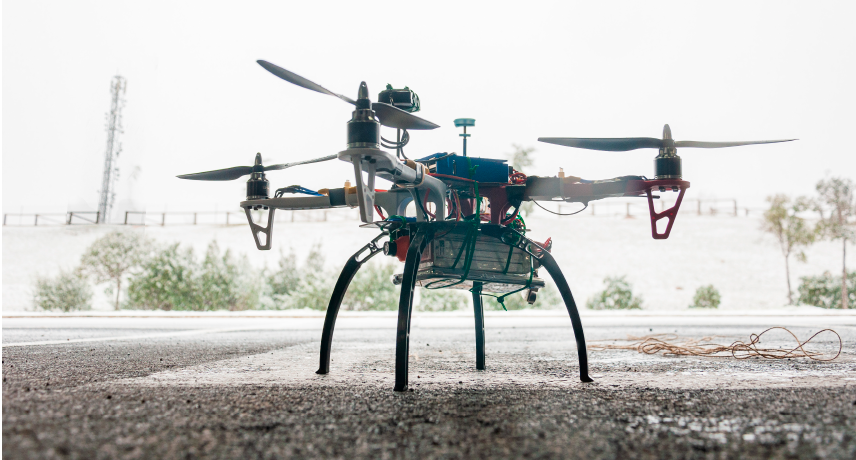
Figure 4. UAV built from scratch to meet the formulated requirements. Note the MDAS subsystem added to the bottom part. added to the bottom